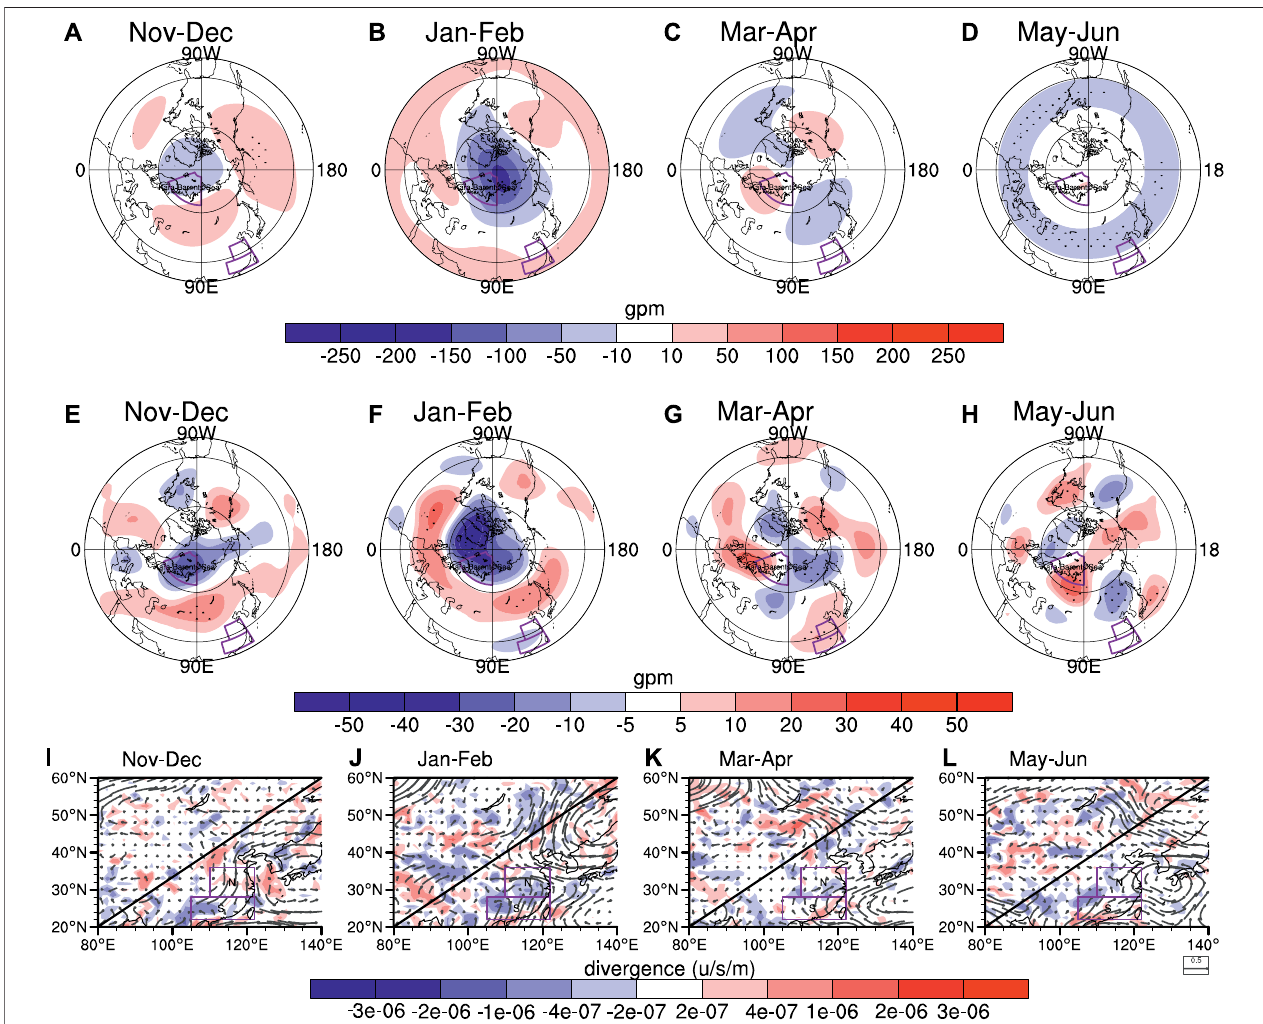
FIGURE 8 | (A – D) Evolution of regressed (top row) geopotential height anomalies at 10 hPa (units: gpm) from November – December to May – June against the standardized November – December mean Arctic sea ice concentration in Barents – Kara Seas. The dotted regions show the regression at the 95% con fi dence level. (E – H) as in (A – D) but for geopotential height anomalies at 200 hPa. (I – L) as in (A – D) but for horizonal wind anomalies and divergence anomalies at 850 hPa.